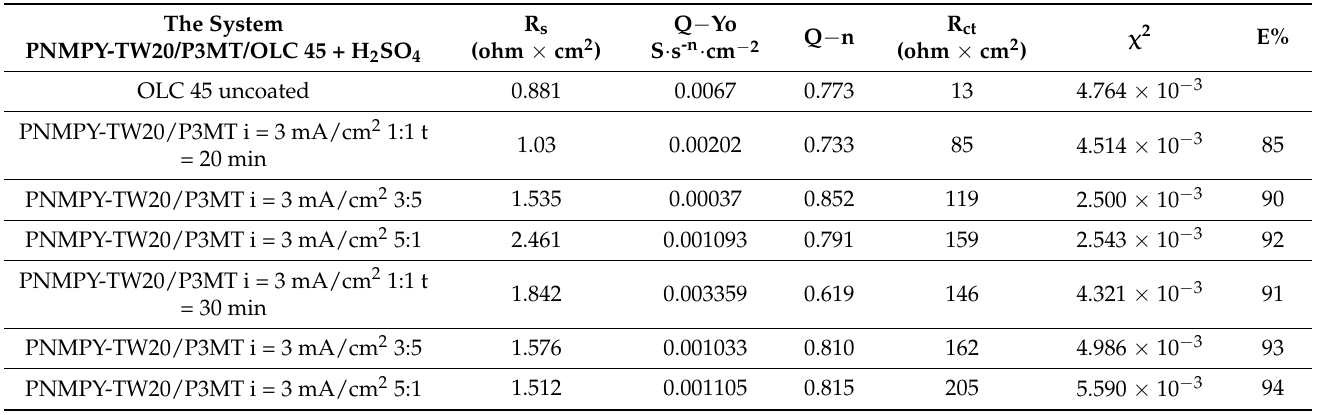
Table 6. EIS parameters of uncoated and coated by PNMPY-TW20/P3MT of OLC 45 sample in 0.5 M H 2 SO 4 medium at 25 ◦